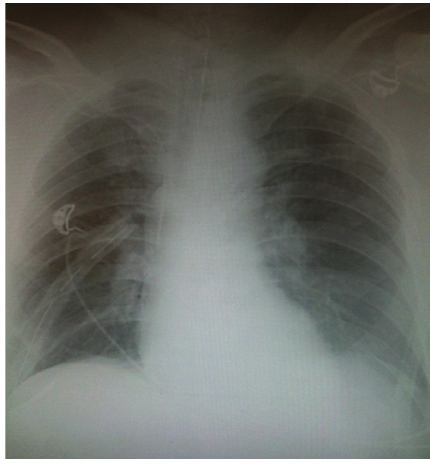
Figure 2: X-ray depicting repair of diaphragm.